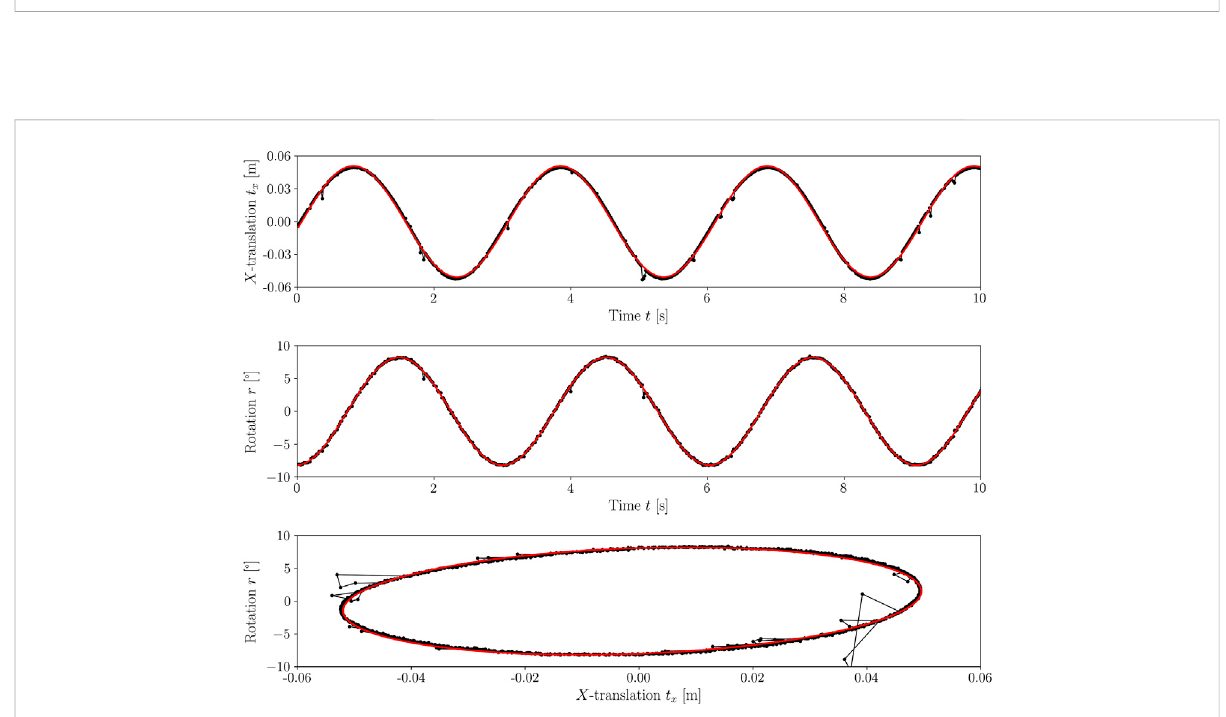
FIGURE 3 The fi gure shows the movement of the CELL-tainer for a setting of 8.2 ° and a rocking rate of 20 rpm. The rotation and translation measured by the motion capturing method are shown in black and the fi ltered and fi tted function are shown in red. In the upper part of the sub- fi gure, the translation of the CELL-tainer is shown, and in the middle the rotation, each for a period of 10 s. The corresponding phase space is shown